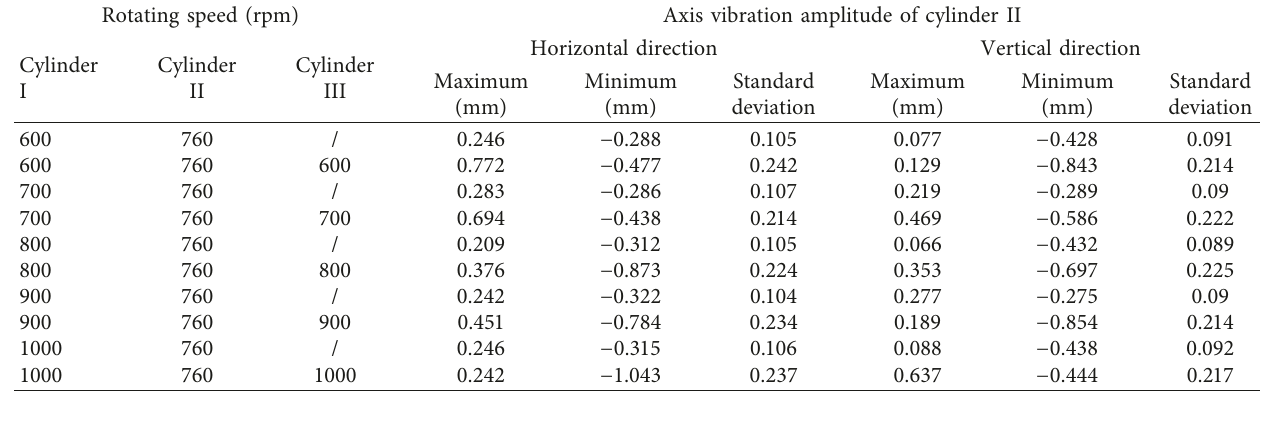
Table 5: Axis vibration of cylinder II under different conditions.